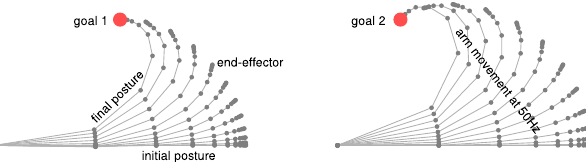
Figure 4. Visualization of the reaching motion (after learning) for ‘goal 1’ and ‘goal